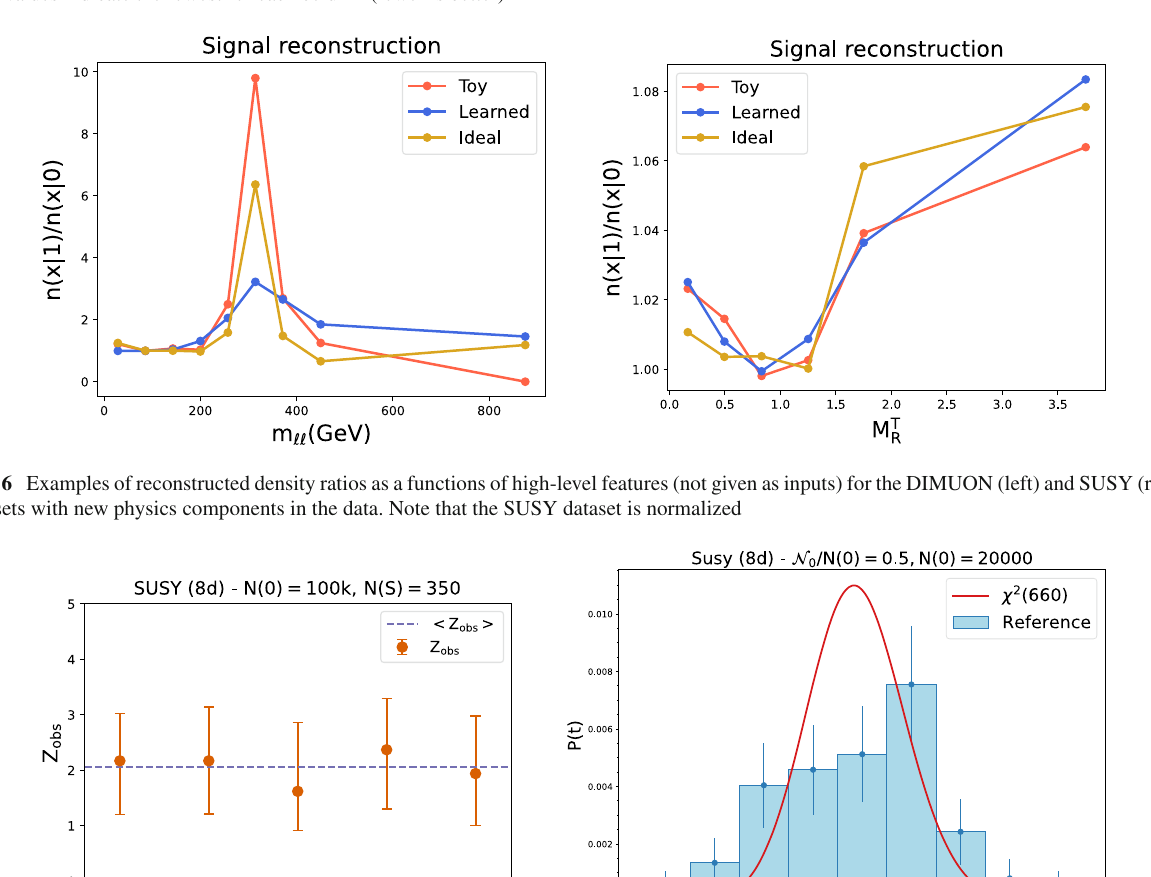
Bold values indicate the lowest for each column (lower is better)